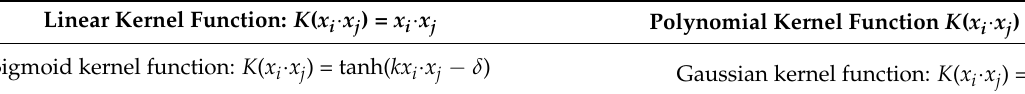
Table 6. Common kernel function types in